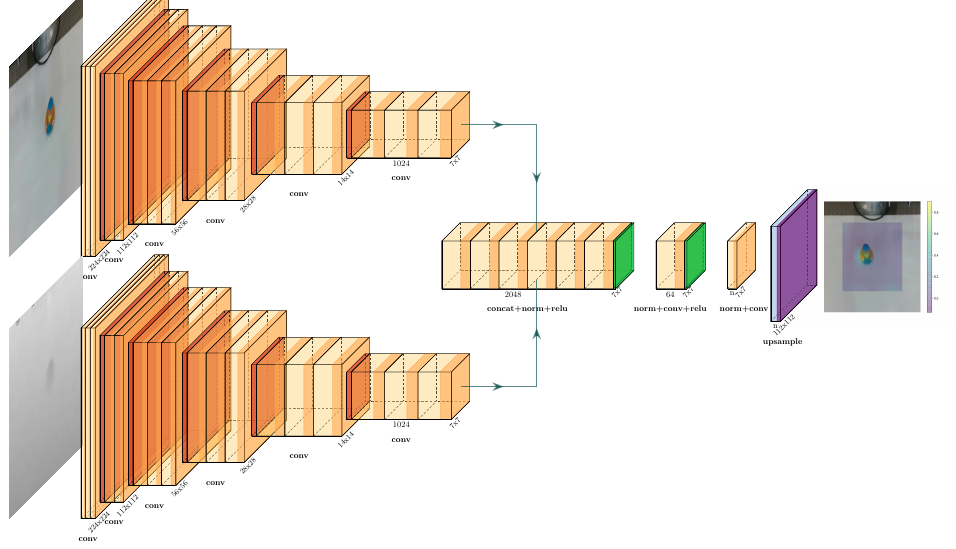
Figure 5. The CNN architecture for the action space S a . The two main blocks are a simplified representation of pre-trained Densenet model. Only the feature size is represented. The features from the Densenet model are concatenated and used to feed the CNN that generates the Q-values used to determine the robot